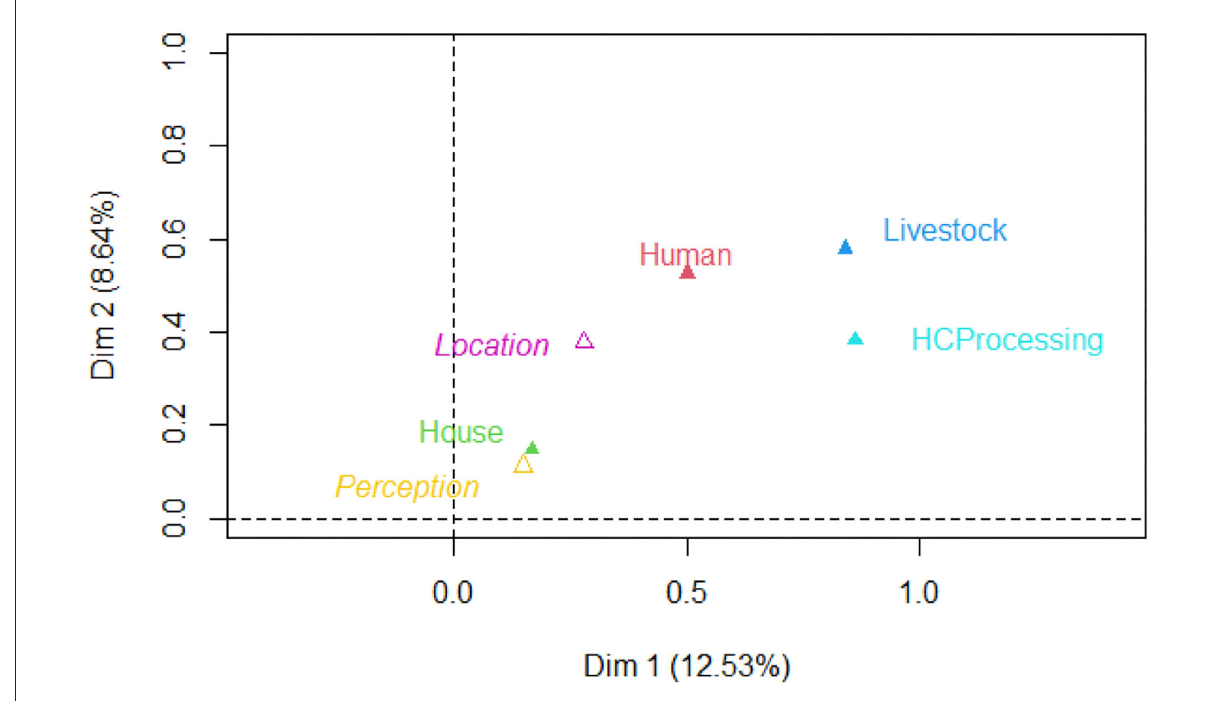
FIGURE7 Inter structure of different and themes for